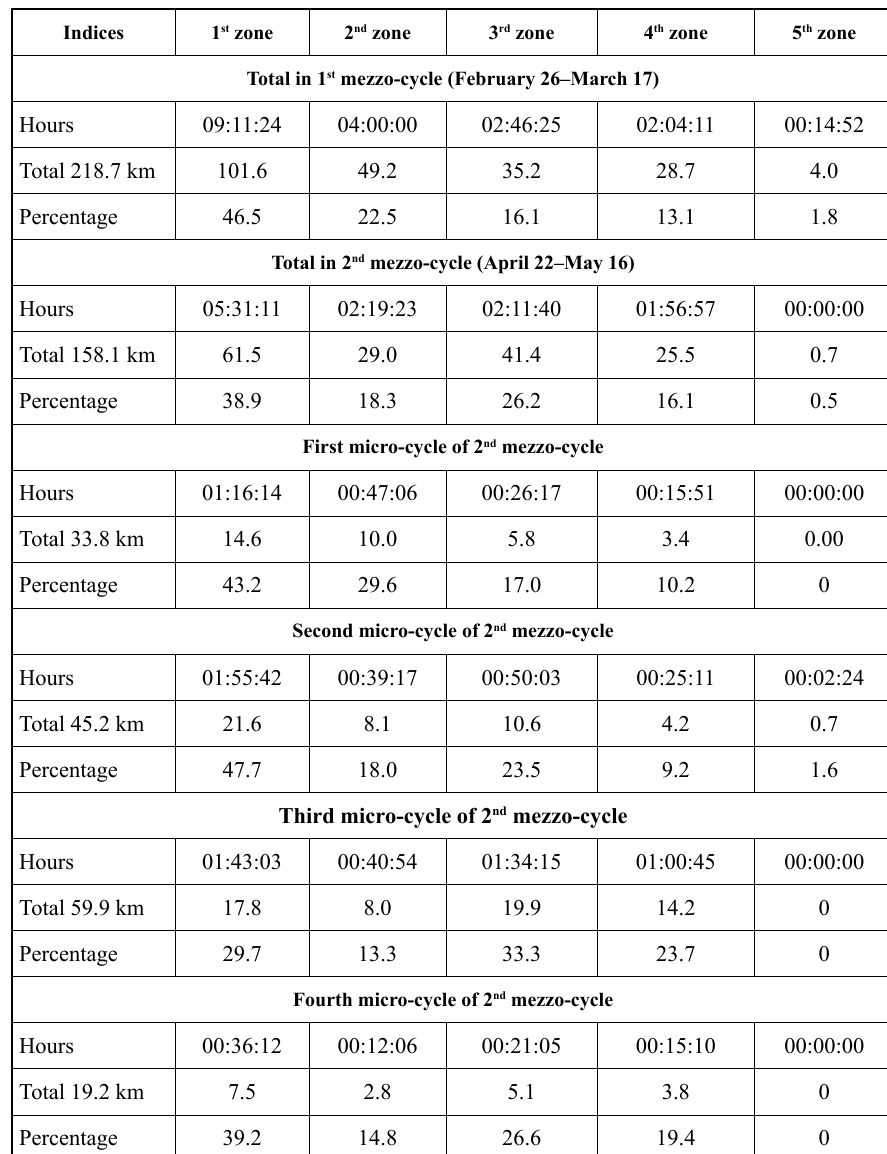
Table 1. characteristics of kayak rower R. N. in on- water rowing work in the preparation and competitive mezzo-cycle of February 26–May 16, 2013